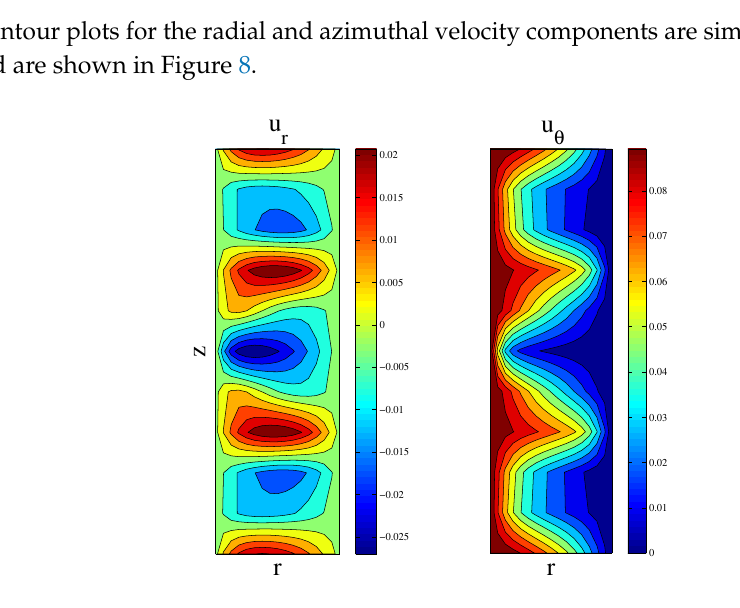
Figure 8. Contours of the radial and azimuthal velocity components for the constant angular speed